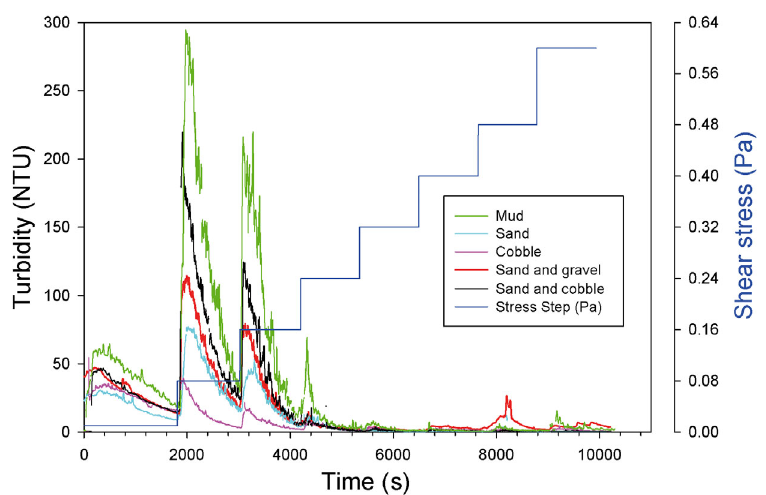
Fig. 1. Turbidity versus time plot from the Gust erosion studies of salmon aquaculture waste material on different bottom substrates (mud, sand, cobble, sand and gravel, sand and cobble). The plot was generated from Campbell turbidity sensors attached to the Gust erosion chamber. Shear stress was increased in discrete steps to a maximum of 0.60 Pa